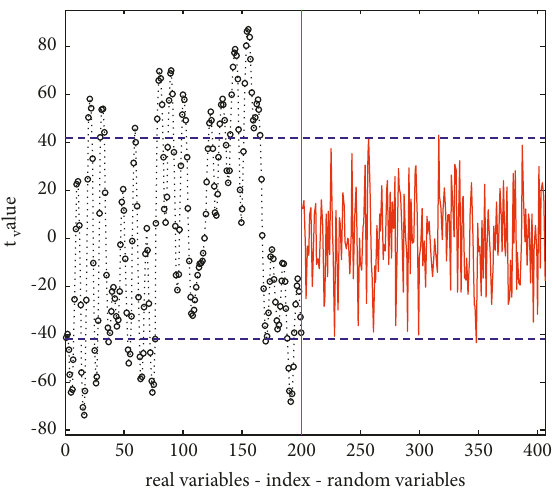
Figure 3: Selection results of UVE characteristic frequency